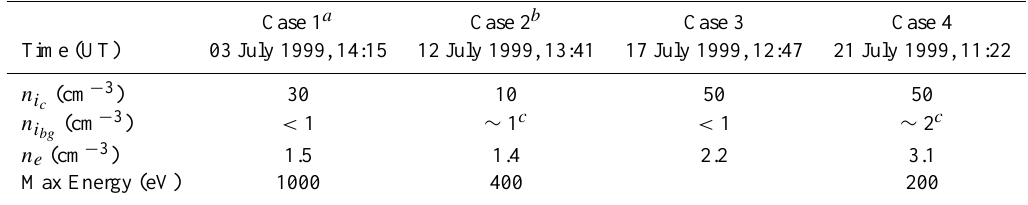
Case 1 a Case 2 b Case